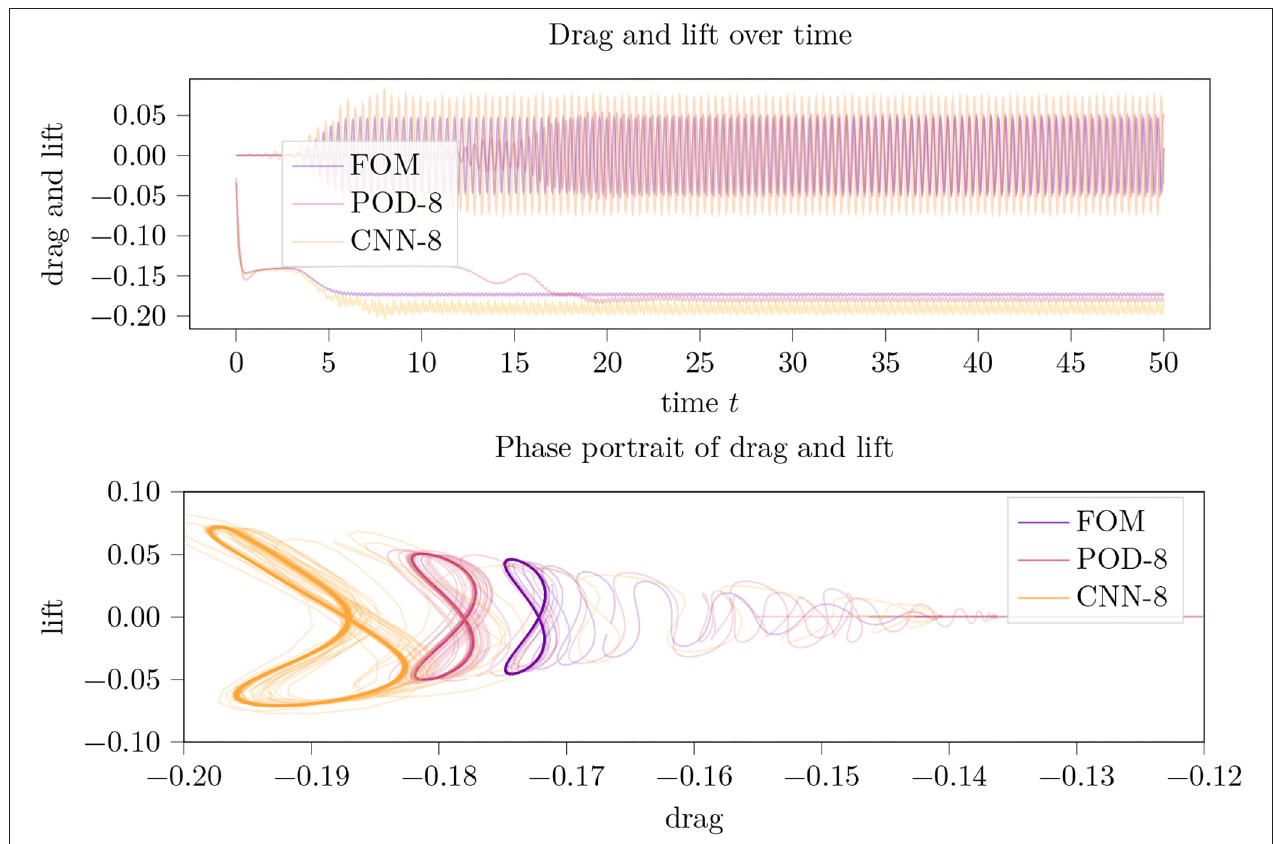
FIGURE 6 | Drag and lift trajectories (top) over time and their phase portrait (bottom picture) for an LPV approximation of the incompressible flow around a 2D cylinder using a parameter dimension of cs = 8